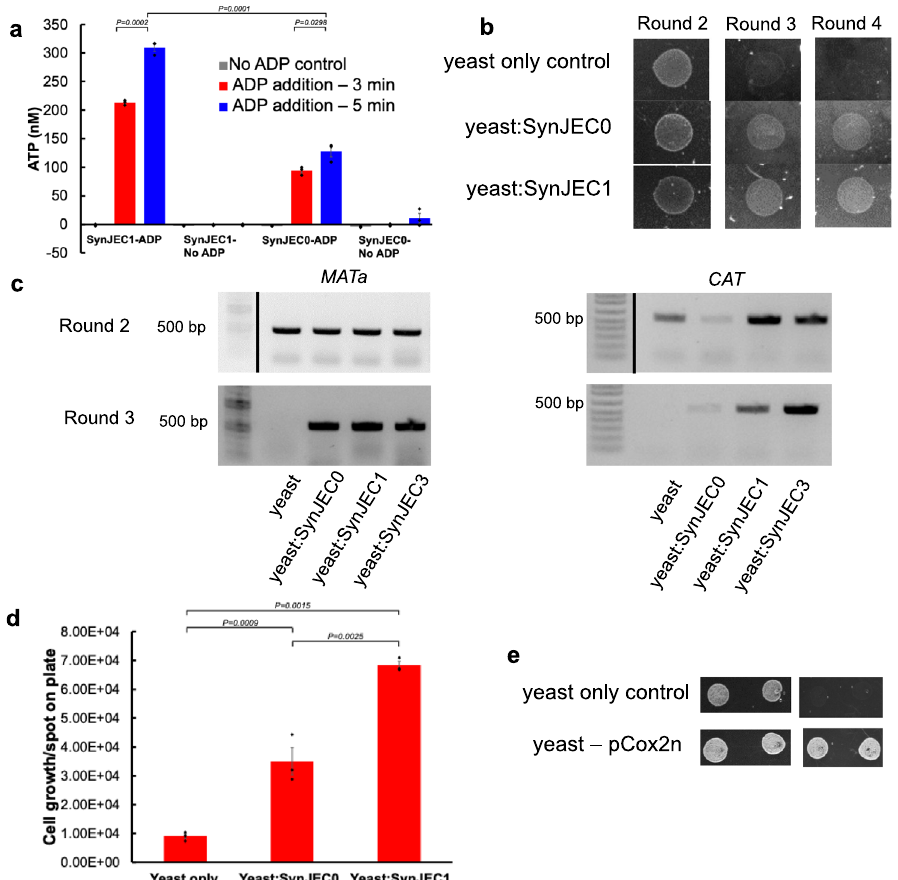
Fig. 2 S. cerevisiae – SynJEC chimeras have a partially rescued respiration-competent phenotype. a Release of ATP by SynJEC1 cells expressing the UWE25 ADP/ATP translocase in the presence of 80 μ M ADP in comparison to SynJEC0 cells. ATP was released when SynJEC1 (expressing the ATP/ADP translocase) and SynJEC0 cells were challenged with extracellular ADP (80 μ M), but not with a blank solution lacking ADP ( N = 3 biological replicates; data are presented as mean values + / − SEM). Two-sided t -tests were used to compare means without adjustments (95% CI, Cohen ’ s d = 10.6, DF = 4, P = 0.0002; 95% CI, Cohen ’ s d = 13.0, DF = 4, P = 0.0001; 95% CI, Cohen ’ s d = 2.7, DF = 4, P = 0.0002). b Growth of S. cerevisiae cox2-60 – SynJEC chimeras on medium containing glycerol as the sole carbon source. No growth was observed in round 4 for yeast lacking intracellular SynJEC . The experiment was repeated independently six times with similar results. c Total DNA isolated from spots grown on selection medium III contain the yeast- encoded MAT a gene and SynJEC -encoded chloramphenicol acetyltransferase ( CAT) gene. The experiment was repeated independently six times with similar results. d Growth rate of yeast- SynJEC chimeras on Selection Medium III. Cells (3.00 × 10 3 ) were spotted on Selection Medium III and counted after 72 h growth. ( N = 3 technical replicates; data are presented as mean values + / − SEM.) P -values were calculated by two-tailed t -test comparing the two means. e Panel 1 describes the growth of S. cerevisiae-cox2-60 and S. cerevisiae-cox2-60- pCOX2n under non-selection conditions. Panel 2 describes the growth of S. cerevisiae-cox2-60 and S. cerevisiae-cox2-60- pCOX2n under selection conditions where the rescue in the growth of S. cerevisiae-cox2-60- pCOX2n is observed but no growth is observed for S. cerevisiae-cox2-60 . The experiment was repeated independently three times with similar results. Source data are provided as a Source Data fi